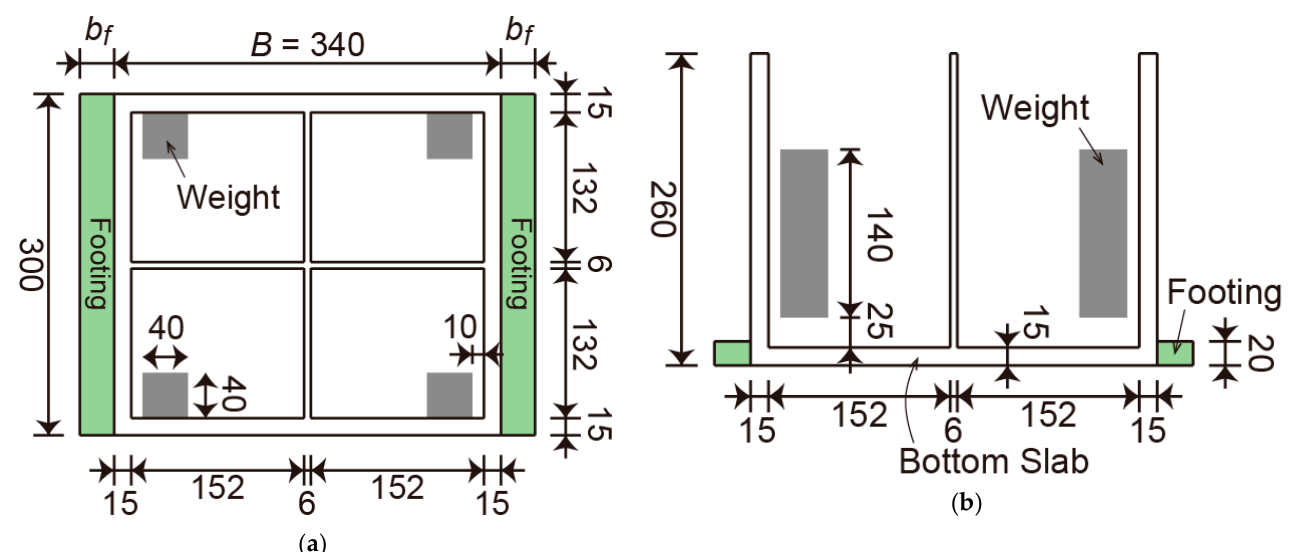
Figure 2. Caisson (unit: mm): ( a ) top view; ( b ) cross-sectional view. Table 1. Specifications of the caisson without the footings.